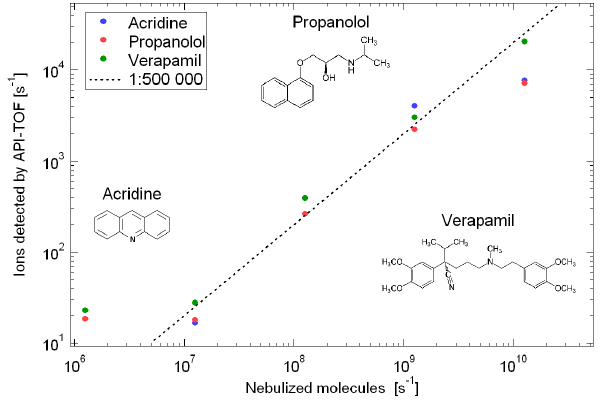
Fig.7. Varyingconcentrationsofthreedifferentorganiccompounds Fig. 7. Varying concentrations of three different organic compounds werenebulizedwithamicrochip,passedthroughabetacharger,and were nebulized with a microchip, passed through a beta charger, and measured by the APi-TOF. The concentration response was linear over the three orders of magnitude. The 1:500000 line is mainly measured by the APi-TOF. The concentration response was linear explainedbythechargingefficiencyofthemolecules,andthetrans- over the three orders of magnitude. The 1:500000 line is mainly mission of the APi-TOF, both probably around 0.1–1%. explained by the charging efficiency of the molecules, and the trans- mission of the APi-TOF, both probably around